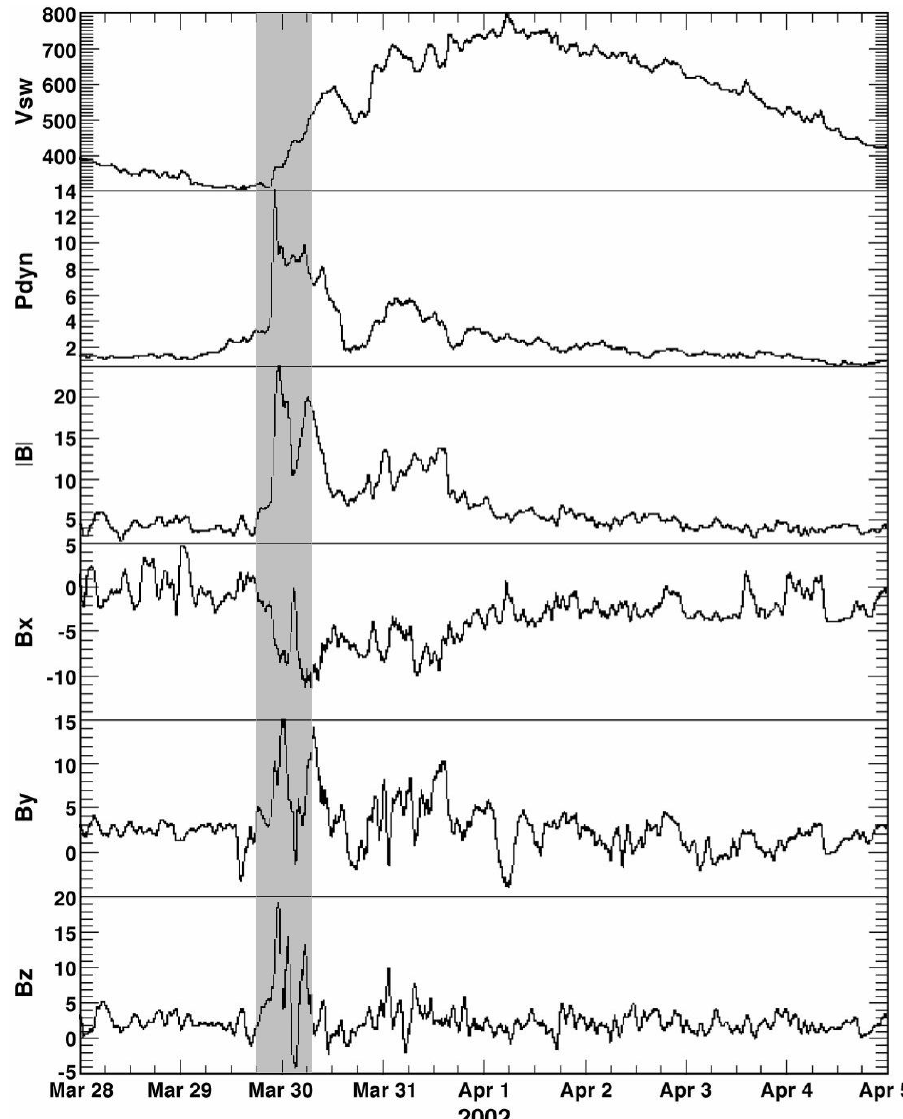
Fig. 9. Average values for the high-speed solar wind stream from 28 March to 5 April 2002. The shaded region shows the nine hour time frame of the vortices searched in Collado-Vega et al.